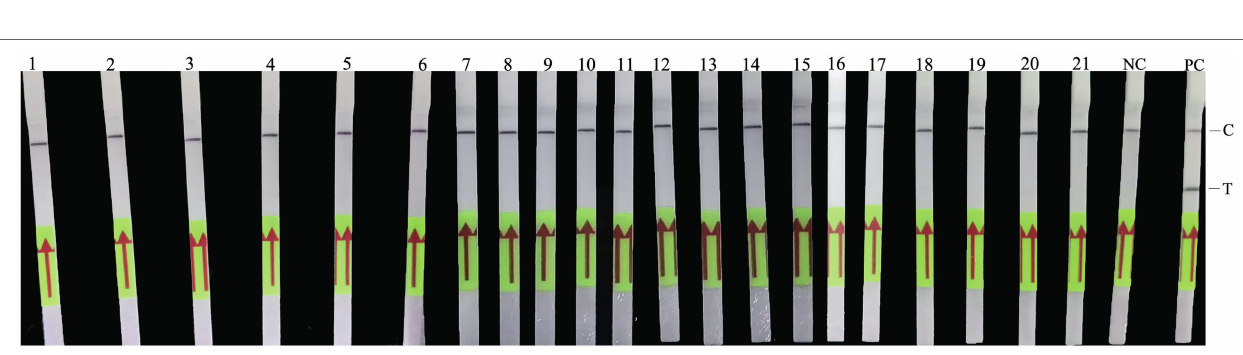
FIGURE 2 | Evaluation of the amplification temperatures and amplification times on the RAA-LF assay. 1 × 10 5 copies/ μ l of C. psittaci DNA was utilized in a 50 μ l RAA reaction mixture and deionized water was provide as negative control. A positive result was determined when both the low line of test (T) and the upper line of control (C) developed. Only C line occurrence indicated a negative result. The RAA-LF worked well in a wide range of amplification temperature from 37 to 42 ° C (A) . After 5–30 min of isothermal amplification reaction, the positive reaction was visible on the test strip (B) .